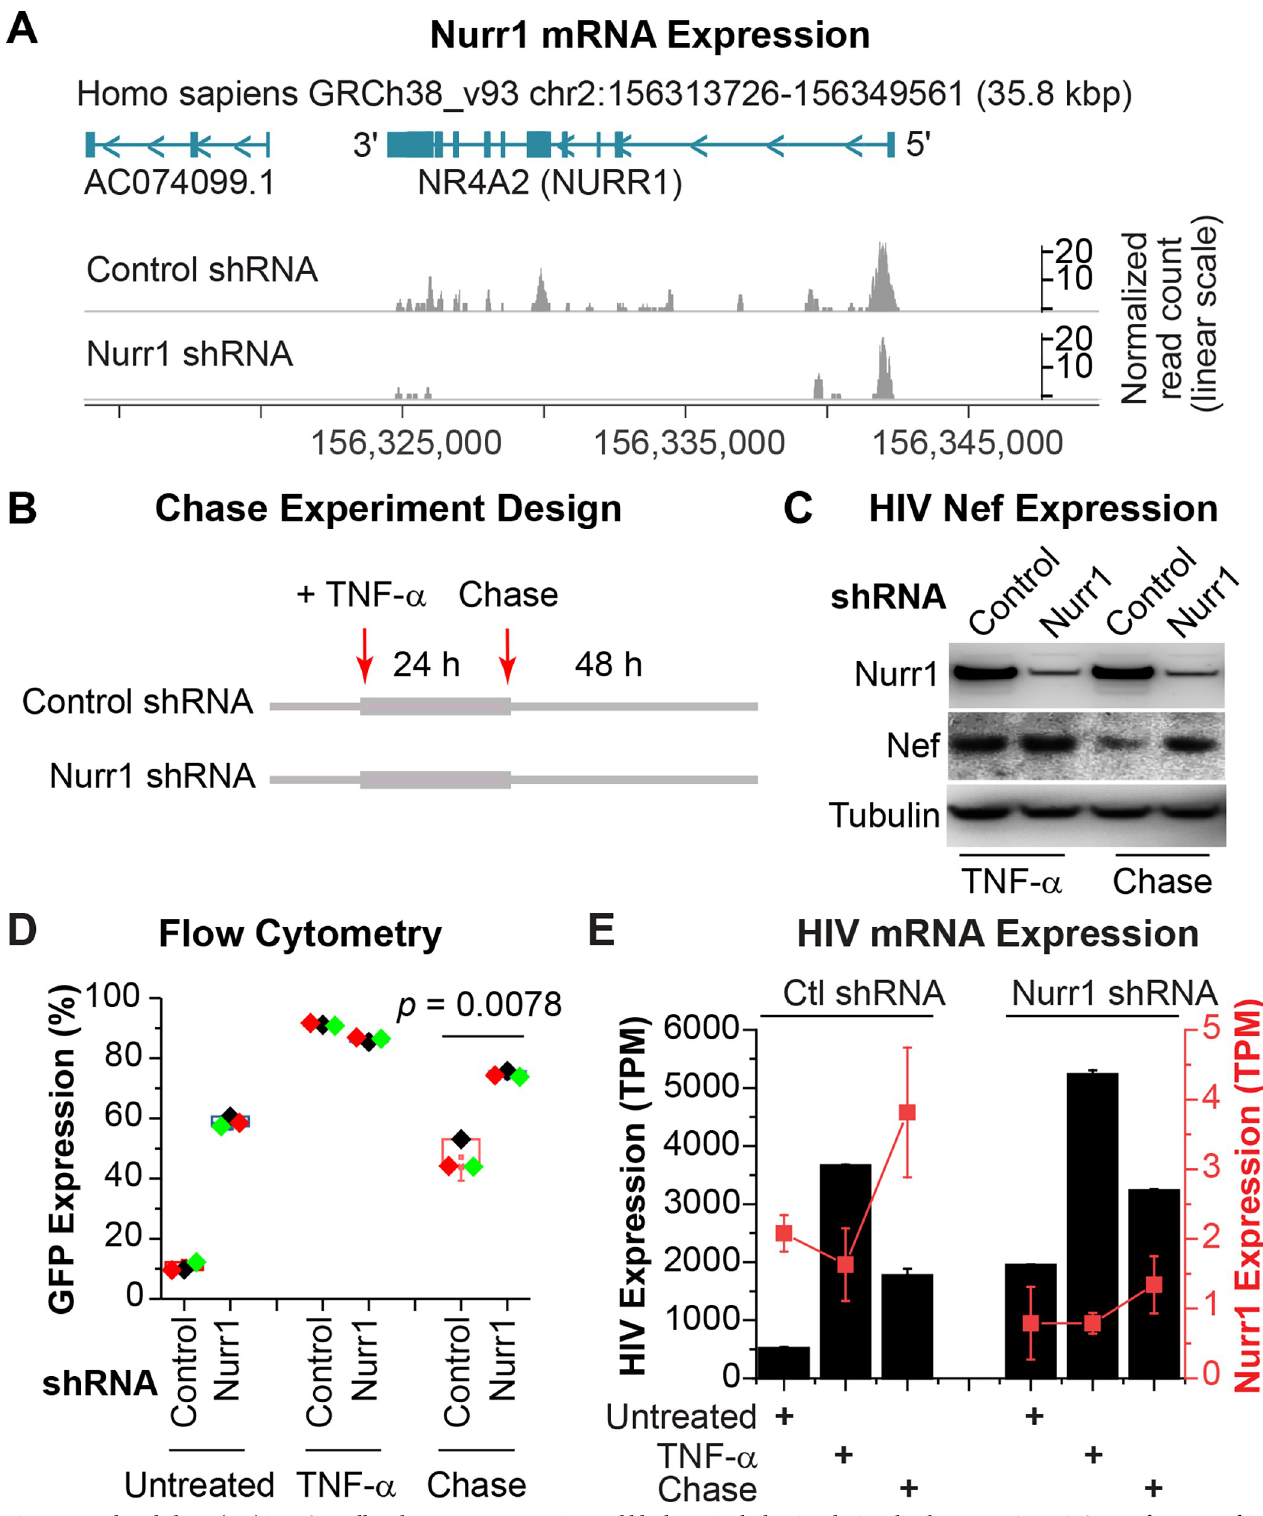
Fig 4. Nurr1 knock down (KD) in HC69 cells enhances HIV expression and block proviral silencing during the chase step. A, RNA-Seq confirmation of Nurr1 KD in HC69 cells. Read histograms for the Nurr1 locus is shown for non-targeting shRNA-infected cells, and cells infected with Nurr1 specific shRNA lentiviral constructs. The Nurr1 shRNAs resulted in a 2.6-fold reduction in Nurr1 mRNA level in the Nurr1 KD cells. Annotated genes for the shown locus are